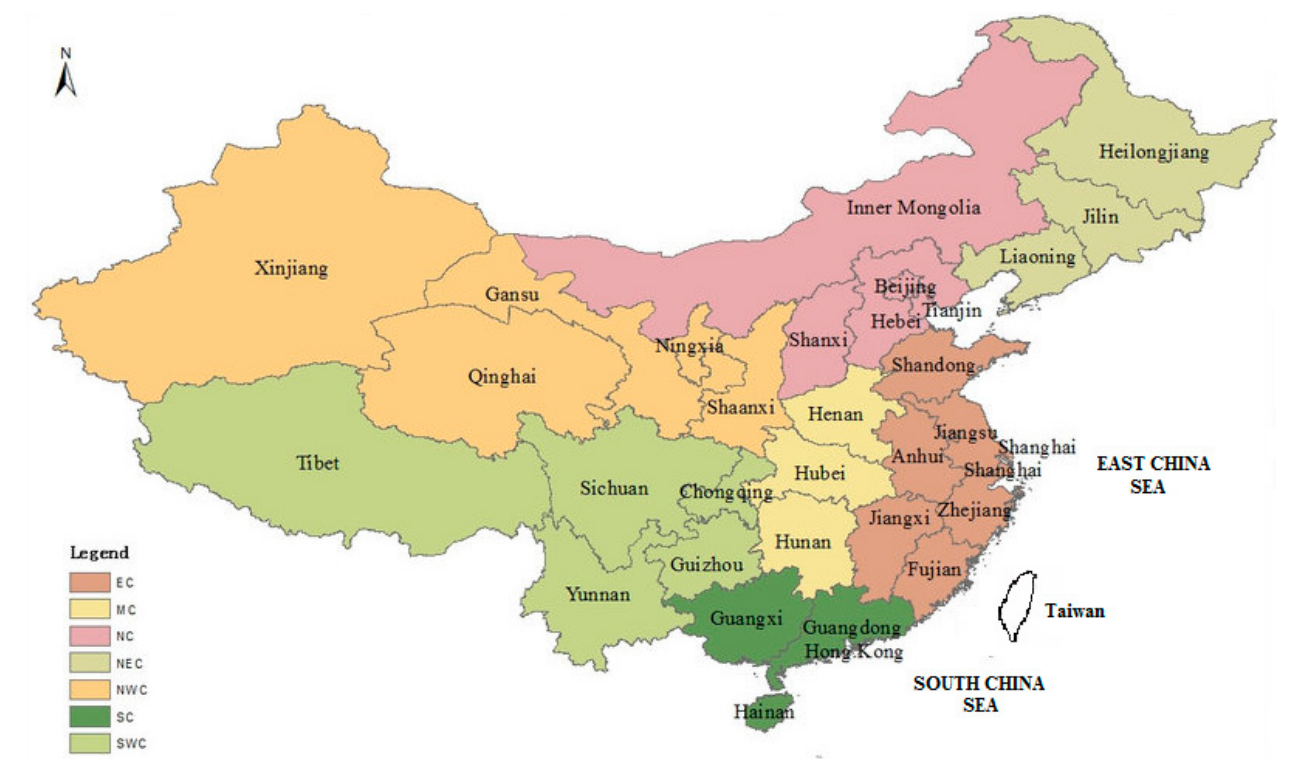
Figure 1. The map lists only the Chinese provinces included in the survey and grouped in geographi- cal areas: East China: EC; South China: SC; Middle China: MC; North China: NC; Northwest China: NWC; Southwest China: SWC; North EastChina: